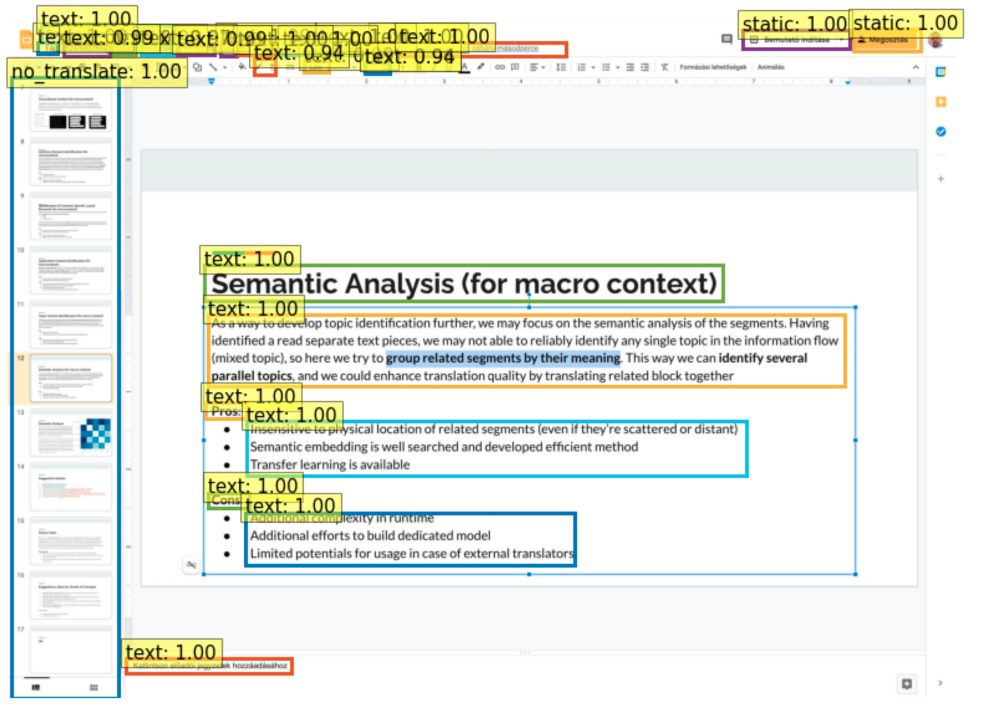
Figure 9. DETR: OCR